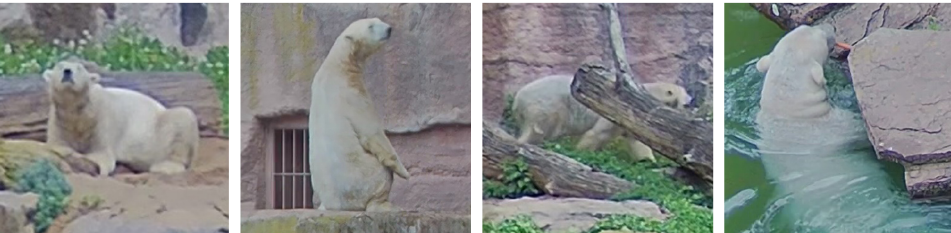
Figure 6. Difficult and unusual instances of the dataset. The first image shows Nanuq in a sandbox far away from the camera. The second image shows Nanuq standing . The third image shows Nanuq partly occluded. The last image shows Vera swimming